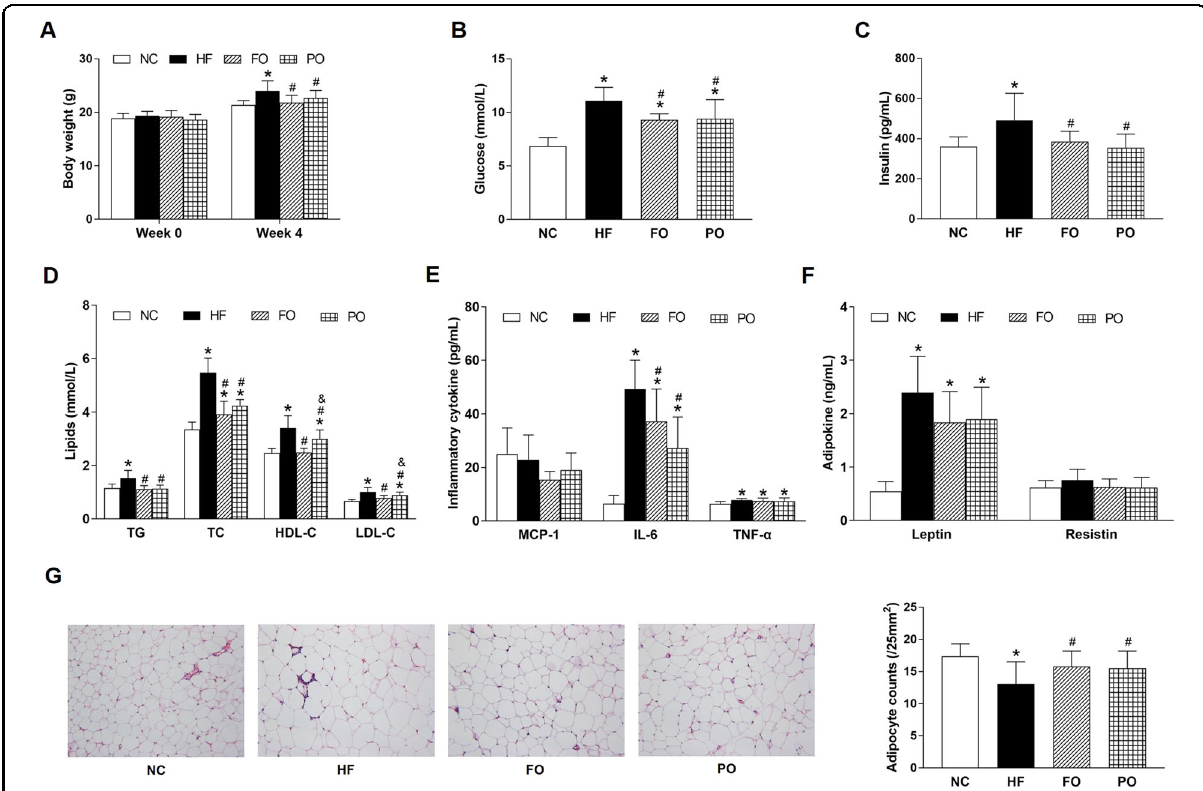
Fig. 1 Effects of FO and PO on glucolipid metabolism, in fl ammation, and adipokine in C57BL/6J mice. A Body weight; B glucose; C insulin; D lipids; E in fl ammatory cytokine; F adipokine; G representative hematoxylin and eosin-stained images (left) and adipocyte counts (right) in adipose tissue. NC normal chow, HF high fat, FO fi sh oil, PO perilla oil, TG triglyceride, TC total cholesterol, HDL-C high-density lipoprotein cholesterol, LDL-C low-density lipoprotein cholesterol, MCP-1 monocyte chemotactic protein-1, IL-6 interleukin-6, TNF- α tumor necrosis factor- α . Data are presented as the mean ± standard deviation. * P < 0.05, compared with NC; # P < 0.05, compared with HF; & P < 0.05, compared with